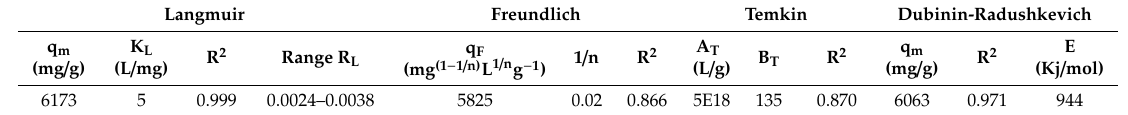
Figure 9. Plots of ( a ) the Freundlich and ( b ) Langmuir isotherms displaying the initial dye concentration effect on the removal of MB by Fe 2 (MoO 4 ) 3 . Table 5. MB removal by Fe 2 (MoO 4 ) 3 isotherm parameters.